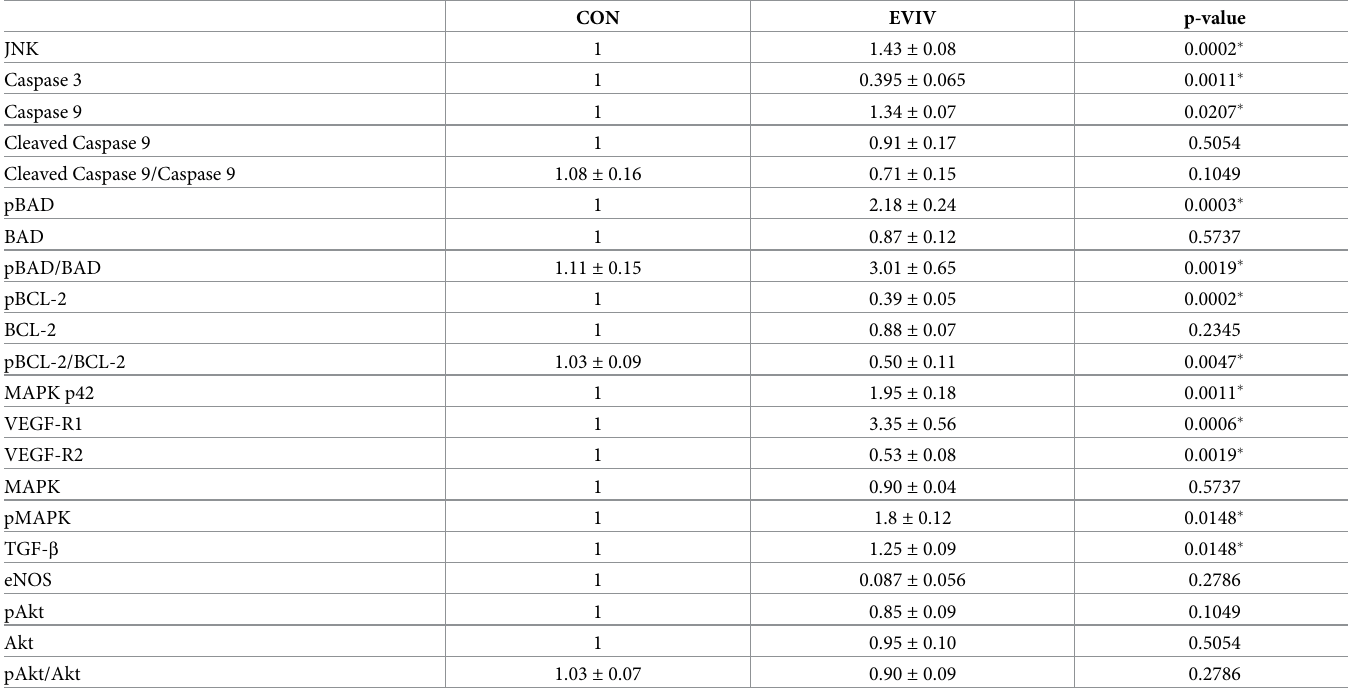
Table 1. Markers of apoptosis and angiogenesis.